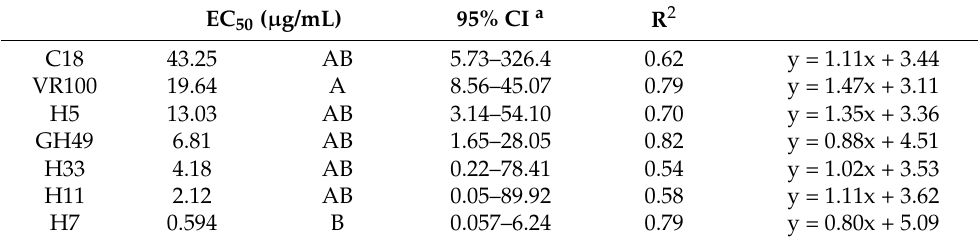
Table 5. Fosetyl-Al mean EC 50 values (effective fungicide concentration that inhibited mycelial growth by 50%) for Phytophthora palmivora isolates from Ghana (GH49 and VR100), Mexico (C18), and Hawaii (H5, H7, H11, and H33) obtained from in vitro assays. Mean separation is based upon whether confidence intervals overlap, columns with the same letter are not significantly different. EC 50 ( µ g/mL) 95% CI